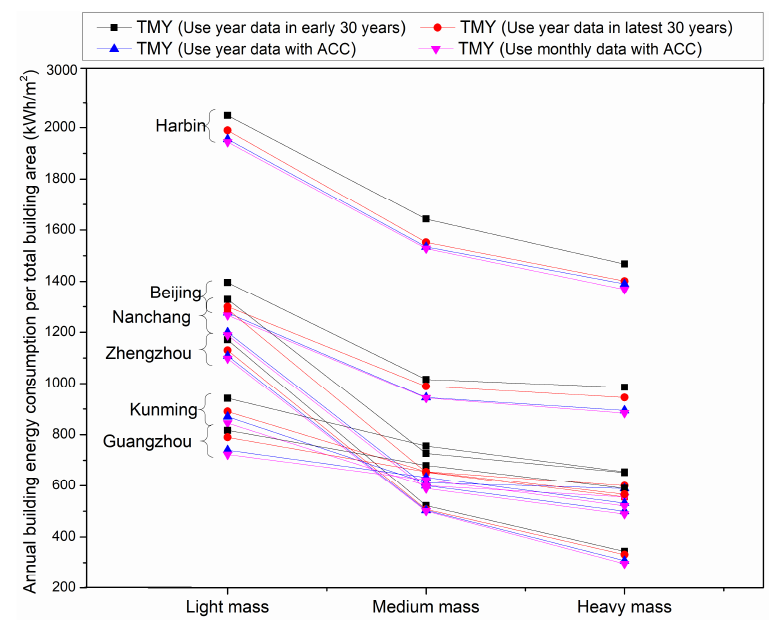
Figure 9. The impact of TMY considering ACC on building energy